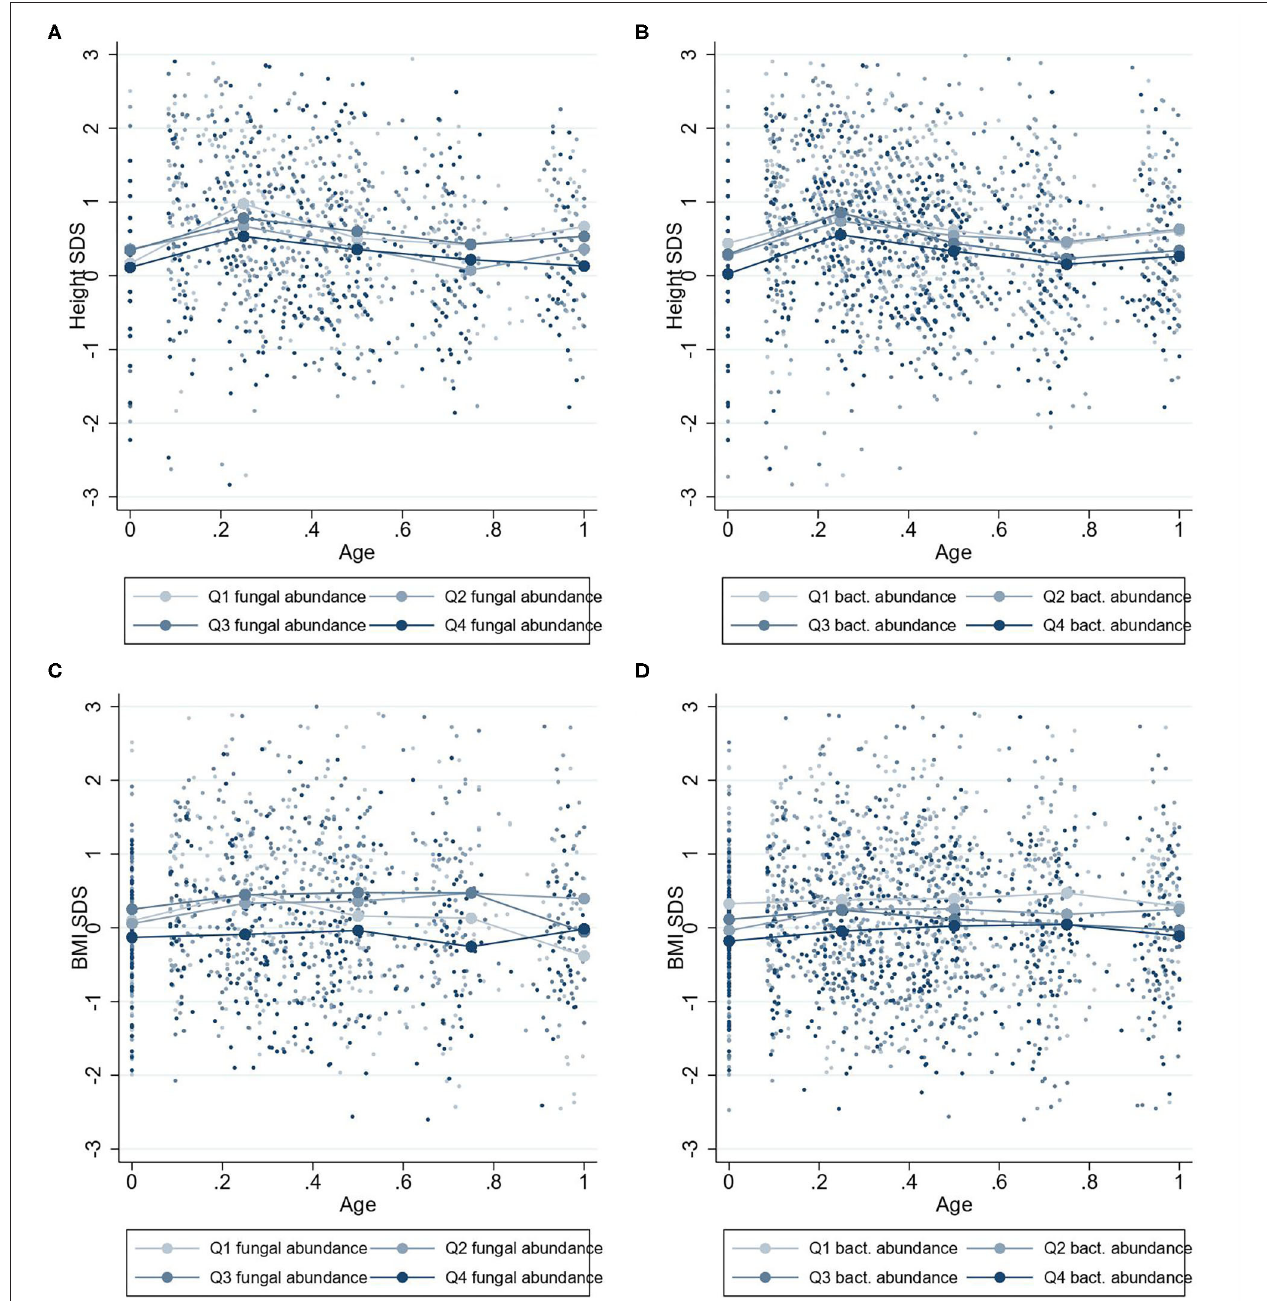
FIGURE 4 | Mean height-SDS and BMI-SDS at 0–1 years according to microbiota abundances at 1 year. Mean standard deviation scores (SDS) values for children at 0–1 year with four quartiles of microbiota abundances at 1 year. Group mean height-SDS at 0–1 year for four quartiles of abundances of fungi (A) and bacteria (B) . Group mean BMI-SDS at 0–1 year for high or low abundances of fungi (C) and bacteria (D) .